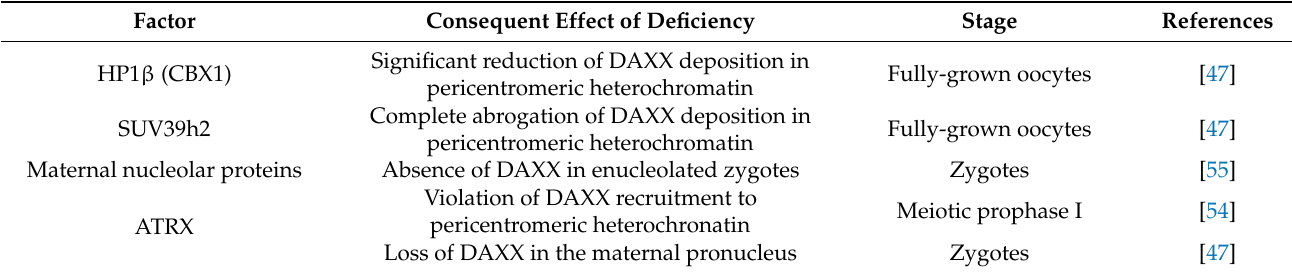
Table 1. Representative factors that regulate DAXX deposition in mammalian oocytes and